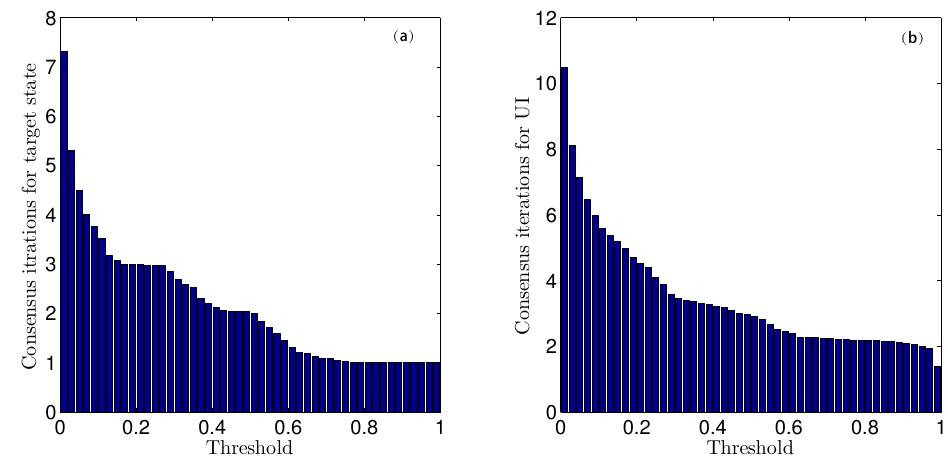
Figure 6. The mean numbers of iteration steps for ( a ) state and ( b ) UI estimation with different